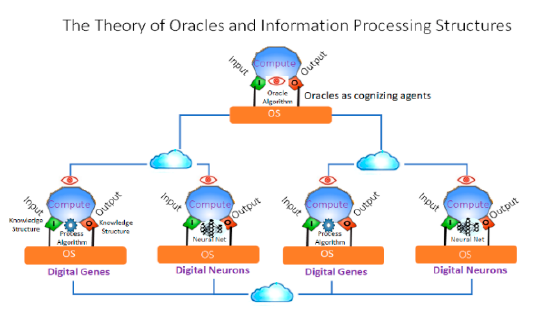
Figure 5. Oracles as cognizing agents managing the execution and evolution of knowledge